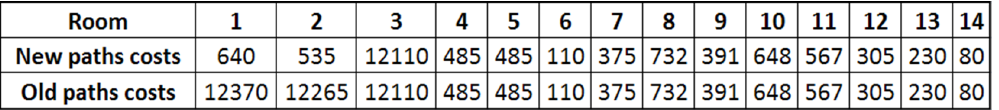
Figure 12. Costs of the new and old escape paths computed with the measurements at t